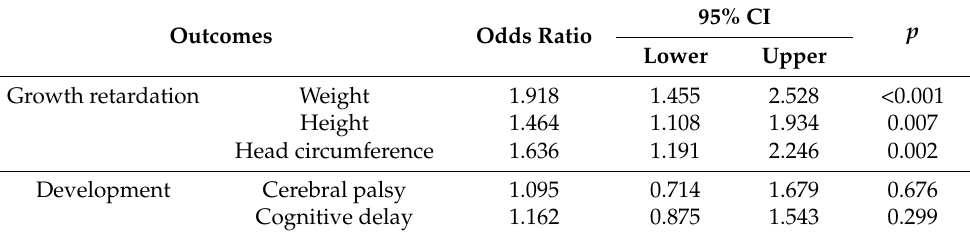
Table 3. Outcomes and influences of thyroid dysfunction requiring L-thyroxine in very low birth weight infants at 2 to 3 years of